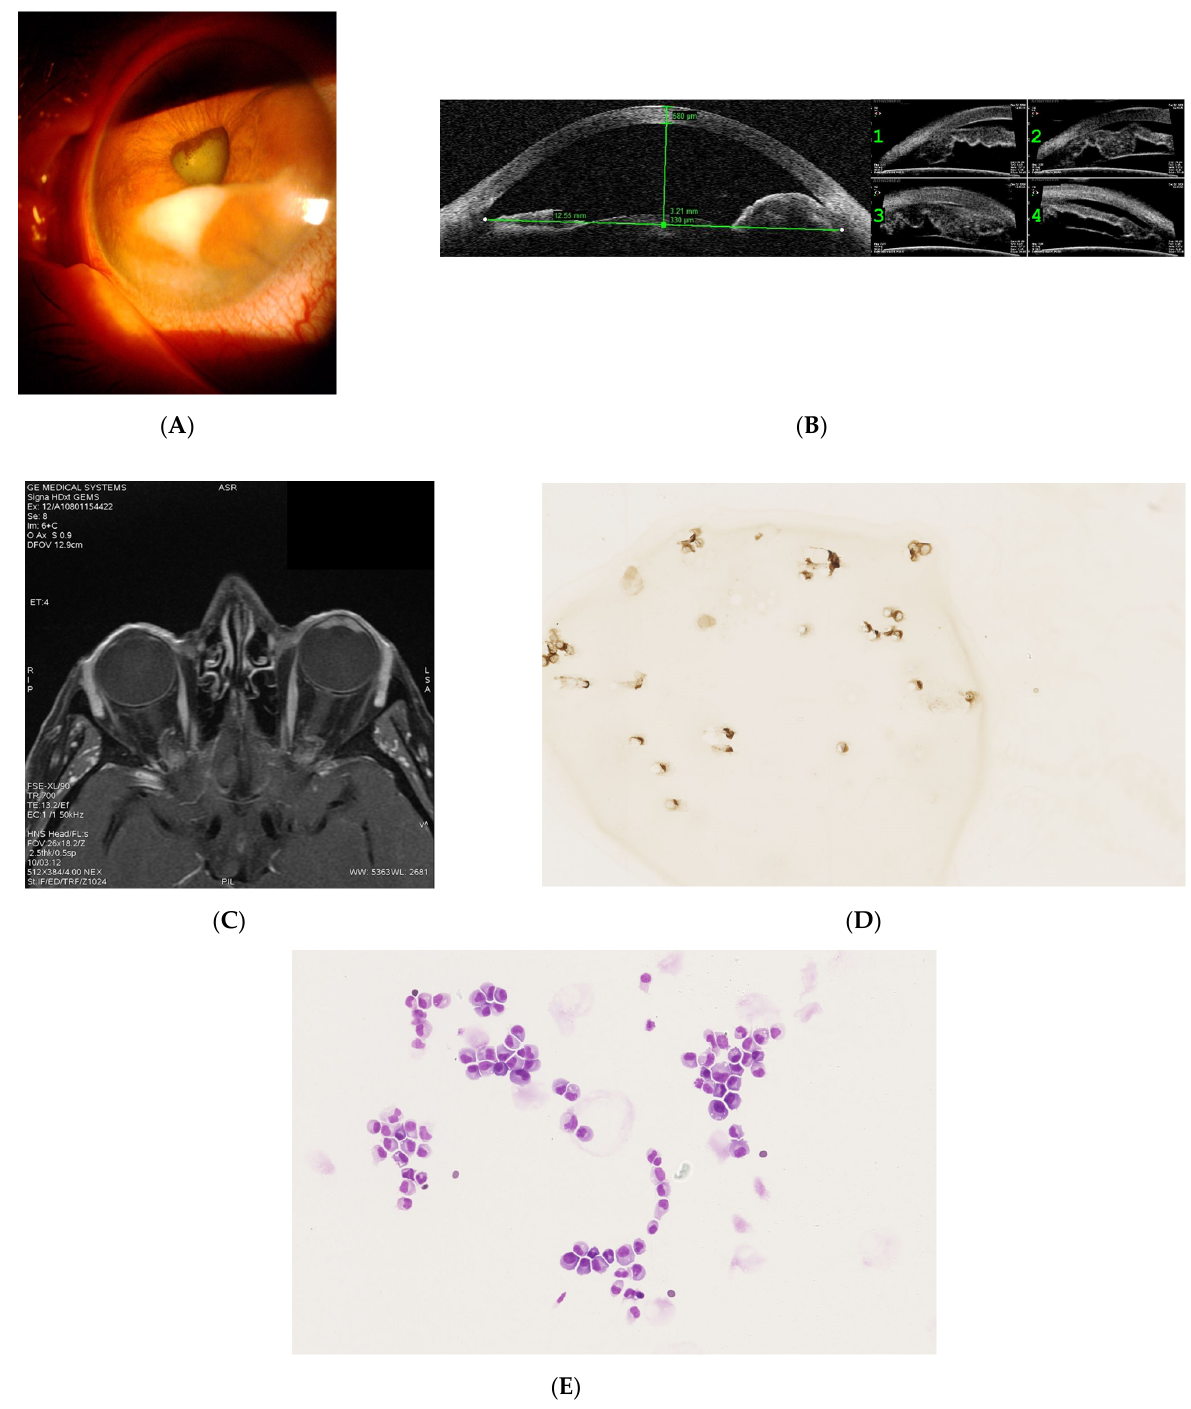
Figure 2. Case 2. ( A ) Slit-lamp photograph of the anterior segment of the left eye, showing anterior chamber involvement; ( B ) Ultrasound biomicroscopy of the left eye showing an iris mass with a tissular infiltrate at the base of the iris. ( C ) Brain IRM. Axial postcontrast fat-suppressed T1-weighted image (3T SIEMENS Skyra MRI scan) passing through the orbits and showing enhancement of the whole anterior chamber of the left eye. ( E ) Fine-needle aspiration biopsy of the lesion in the iris showing plasma cells producing IgG lambda (Immunohistochemistry) and ( D ) atypical plasma cells (May-Grünwald Giemsa).